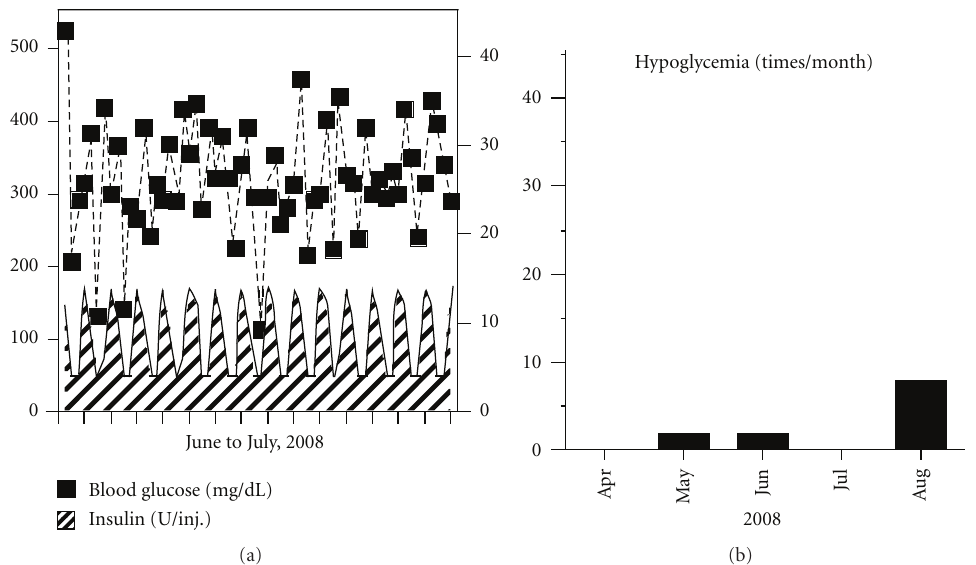
Figure 5: Representative blood glucose profiles after the treatment of octreotide LAR for 4 months. Blood glucose profile and the dose of each insulin injection are shown (a). The duration between ticks on the X -axis represents 24 h. The frequency of hypoglycemia, defined as below 70mg/dL of blood glucose, is shown